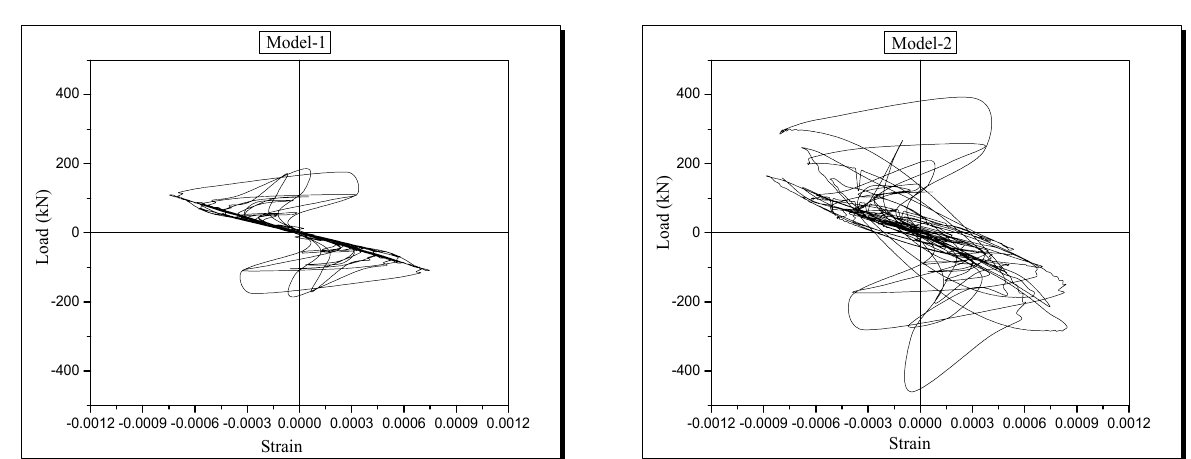
Figure 6: Load Vs strain displacement on timber beam